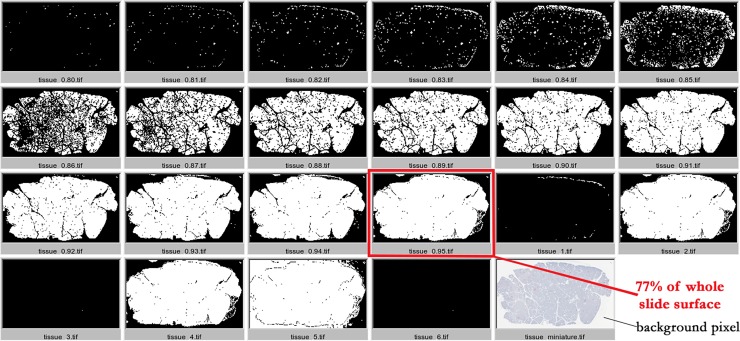
Example on the slide 14262.The first R script, used for the selection of the pixels belonging to total pancreatic tissue, generated 22 different propositions. The choice of the investigator is framed in red and the subsequent result indicated under the picture. An example of background pixel has been also pointed out on the picture miniature.